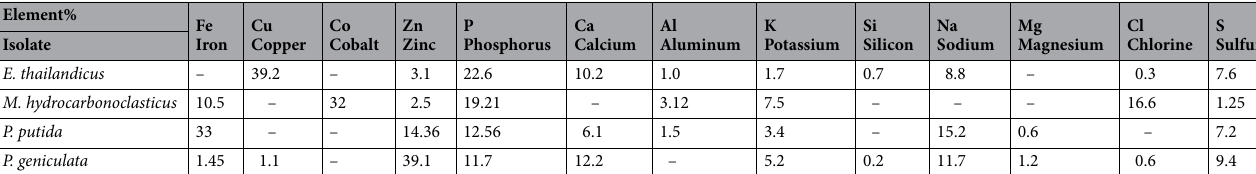
Table 3. Energy-dispersive X-ray analysis of Enterococcus thailandicus E12 cultured on copper nitrate, Marinobacter hydrocarbonoclasticus M 69 cultured on cobalt nitrate, Pseudomonas putida T65 cultured on iron nitrate and P. geniculata G 80 cultured on zinc